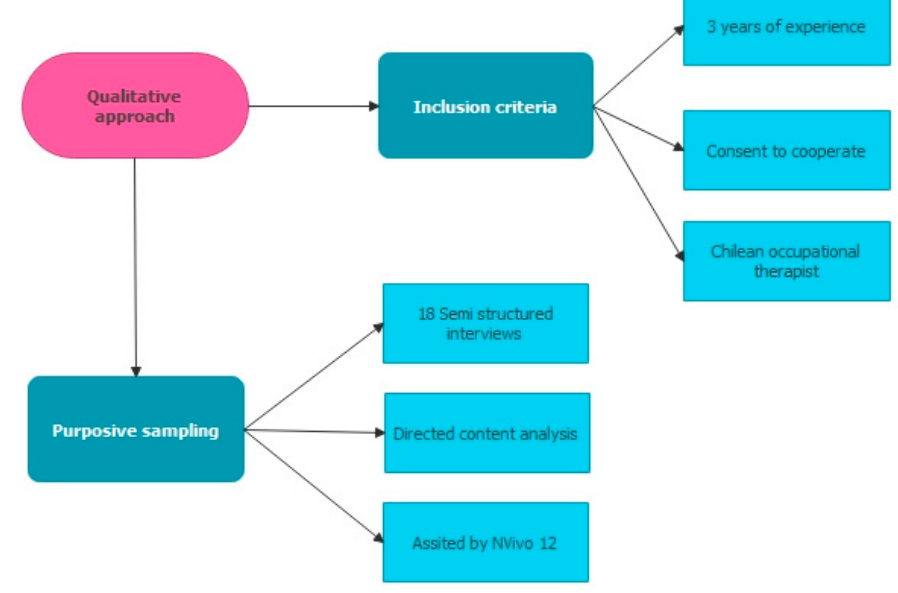
Figure 1. Design of the investigation.